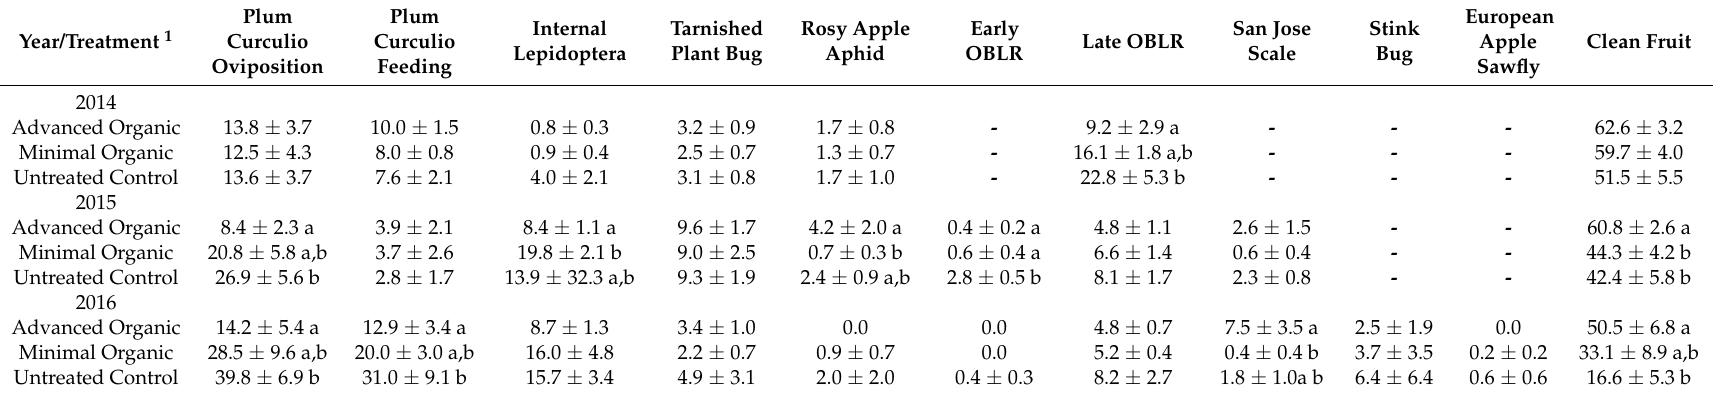
Table 4. Percent fruit insect damage at harvest under different organic programs,